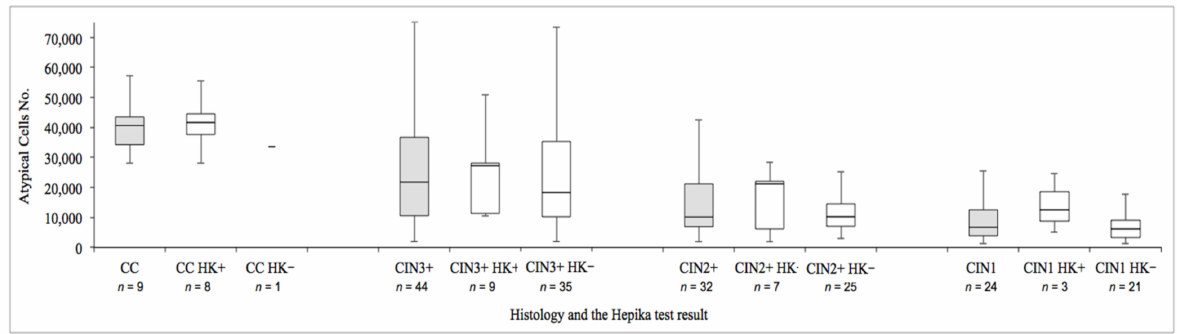
Figure 4. Distribution of atypical cells based on histology and Hepika test result. Data are presented in boxes and whiskers’ style, which represents the medians and ranges of the data. (Abbreviations: CC: carcinoma; CIN: cervical intraepithelial neoplasia (grade 1, 2, and 3); HK: Hepika (positive: +; negative: − ); n: number of